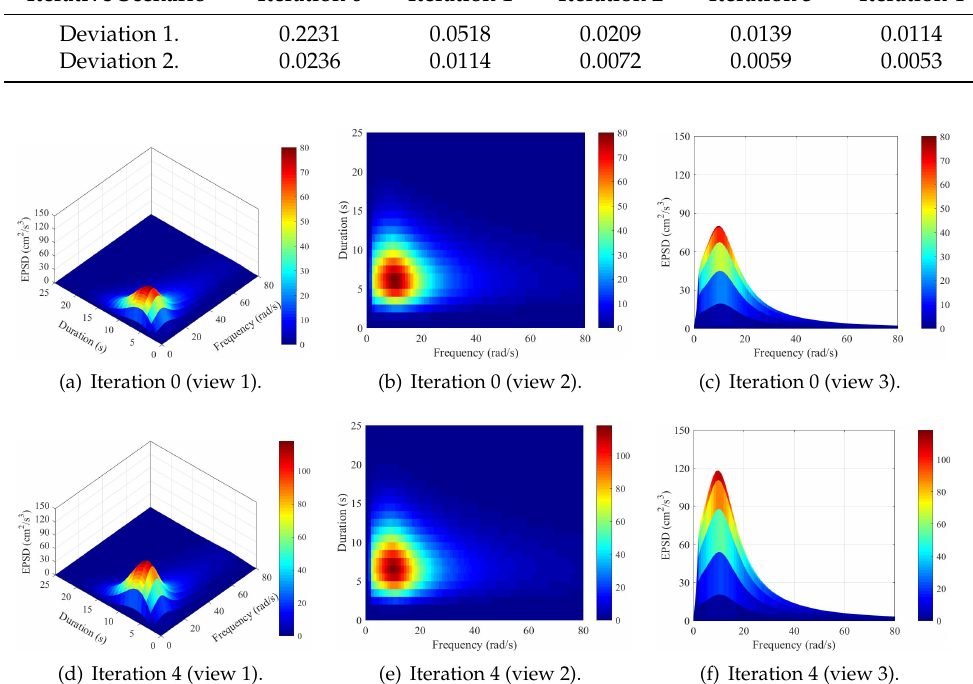
Table 3. The deviations between the target and average spectral acceleration for all four iterative sce- narios. Iterative Scenario Iteration 0 Iteration 1 Iteration 2 Iteration 3 Iteration 4 Deviation 1. 0.2231 0.0518 0.0209 0.0139 0.0114 Deviation 2. 0.0236 0.0114 0.0072 0.0059 0.0053